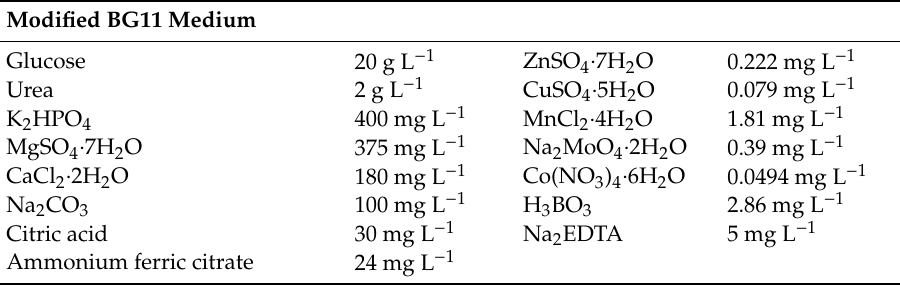
Table 2. Composition of a modified BG11